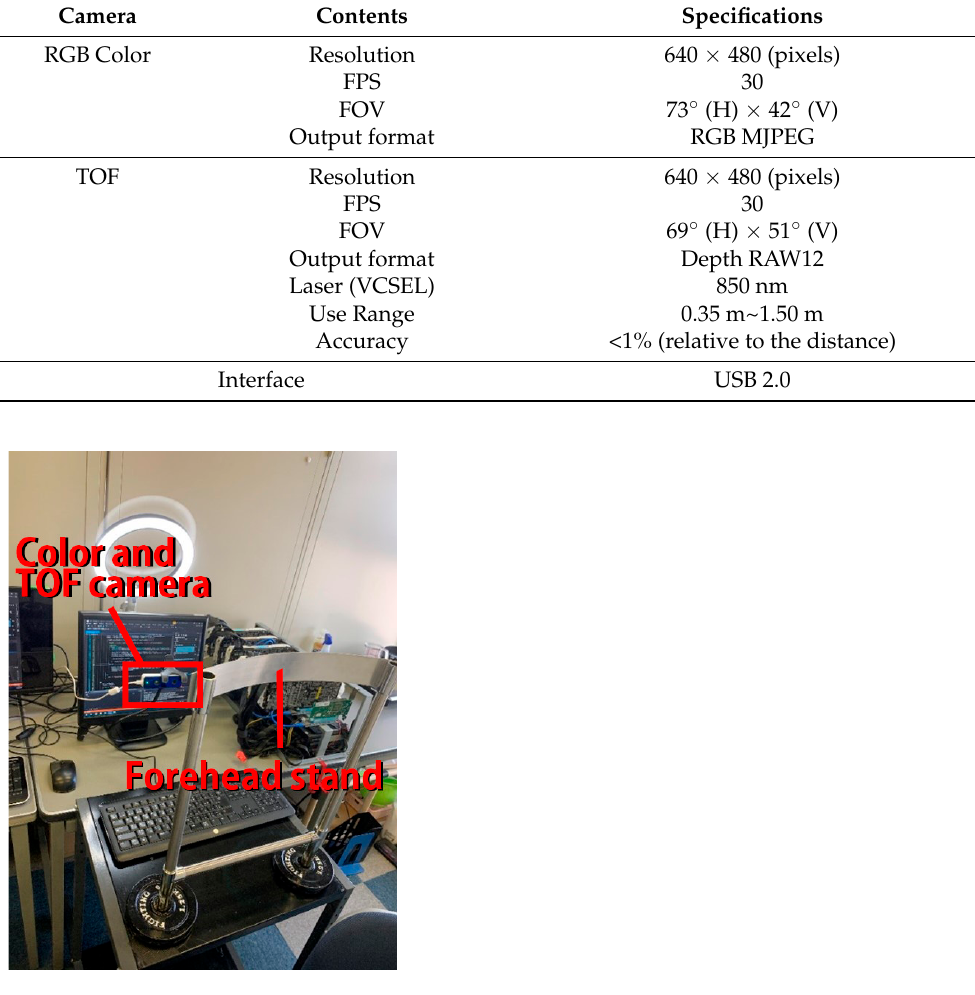
Figure 4. Capturing environment of 3D mouth.